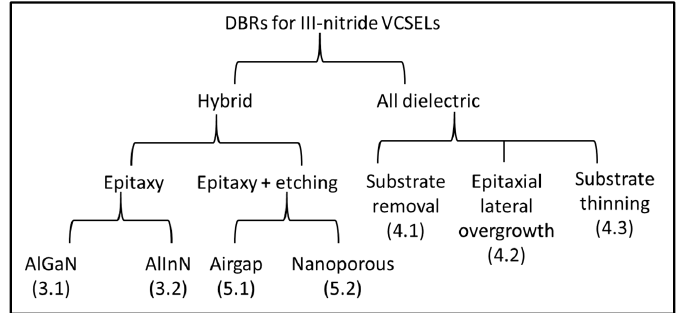
Figure 5. A chart depicting di ff erent approaches to prepare DBRs toward the fabrication of III-nitride VCSEL devices. The corresponding sections of review are labeled at the